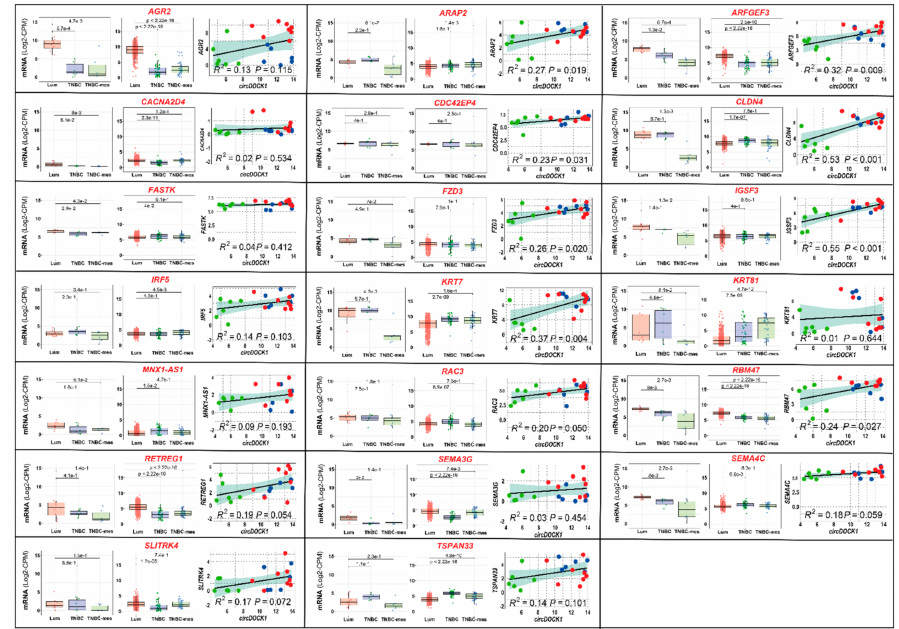
Figure 4. Expression profiles of some of the circDOCK1-1 upregulated genes in breast cancer cell lines and tumour specimens. The indicated mRNAs and single non-coding RNA ( MNX-AS1 ) are coded by some of the genes that are commonly upregulated in MDA-MB-231 and MDA-MB-157 cells overexpressing circDOCK1-1 , according to our RNA-seq data. These RNAs are characterized by a trend towards higher expression levels in the Lum vs. TNBC-mes cell lines belonging to our panel of 18 cell lines (left diagrams of each panel; the p -values of the indicated comparisons are shown, Wilcoxon test). The expression profiles of the RNAs that can be determined from the RNA-seq data obtained from the breast cancer specimens available in the TCGA database are also illustrated (middle diagrams of each panel; the p -values of the indicated comparisons are shown, Wilcoxon test). The right diagrams of each panel show the quantitative correlations between the levels of the indicated mRNA and circDOCK1-1 in each breast cancer cell line considered. TNBC-mes , TNBC and Lum cell lines are indicated by the green, blue, and red dots, respectively. The calculated R 2 correlation value (Pearson method) and the correlation p -value are